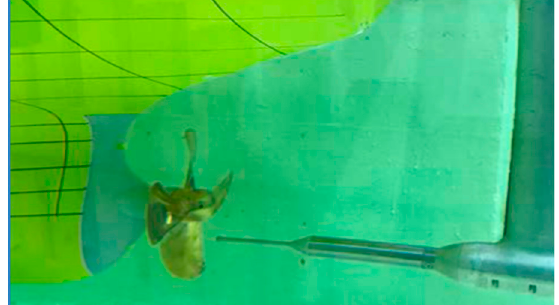
Figure 16. 3D wake measurements setup.